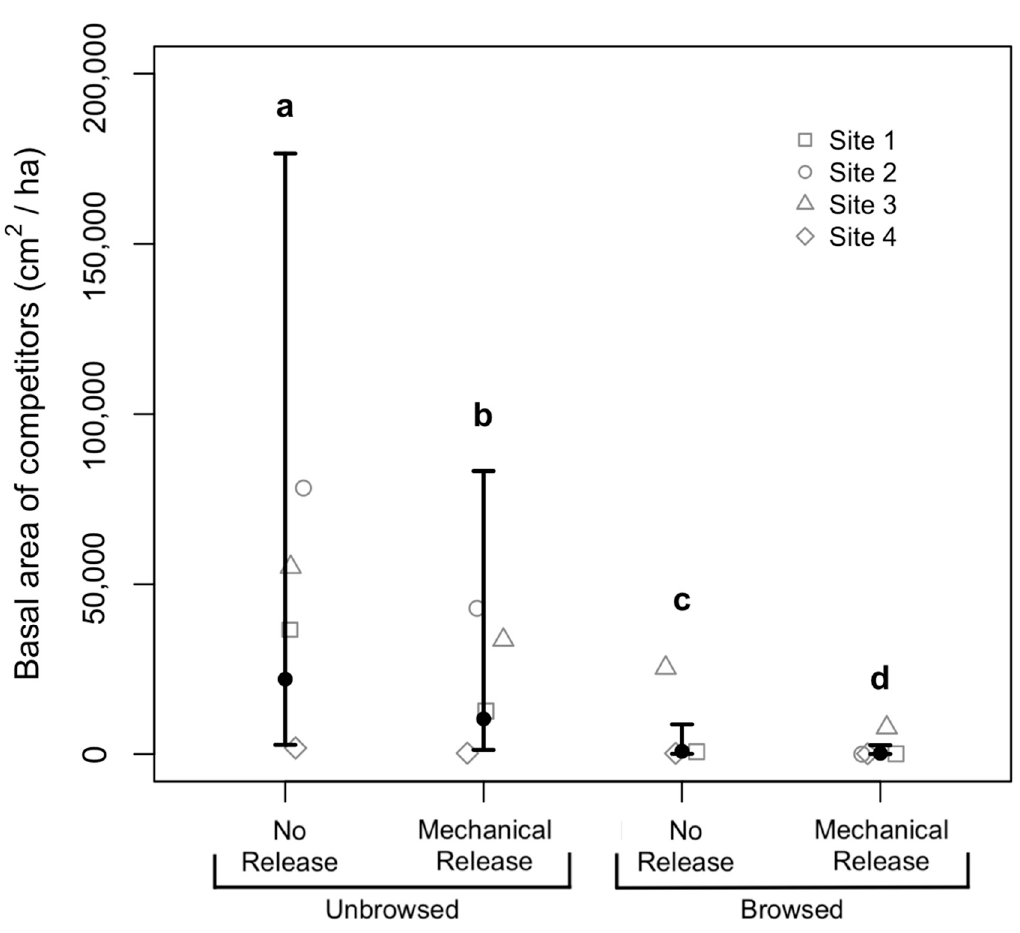
Figure 3. Basal area of the competing tree saplings in four white spruce plantations receiving combinations of browsing exclusion (unbrowsed or browsed) and forest cleaning (no release or mechanical release) treatments. Predicted values were estimated from a generalized linear mixed model with a negative binomial distribution and with the forest cleaning treatment nested within the browsing exclusion treatment, nested within the site, as a random factor. Error bars are 95% confidence intervals. Raw averages are shown in gray. Treatments that do not share at least one similar letter are significantly different at p = 0.1.